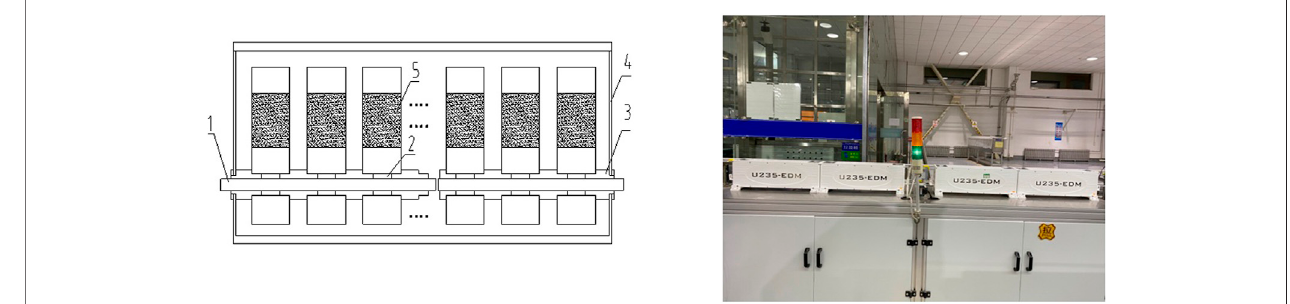
FIGURE 5 | Array of multi-probe passive